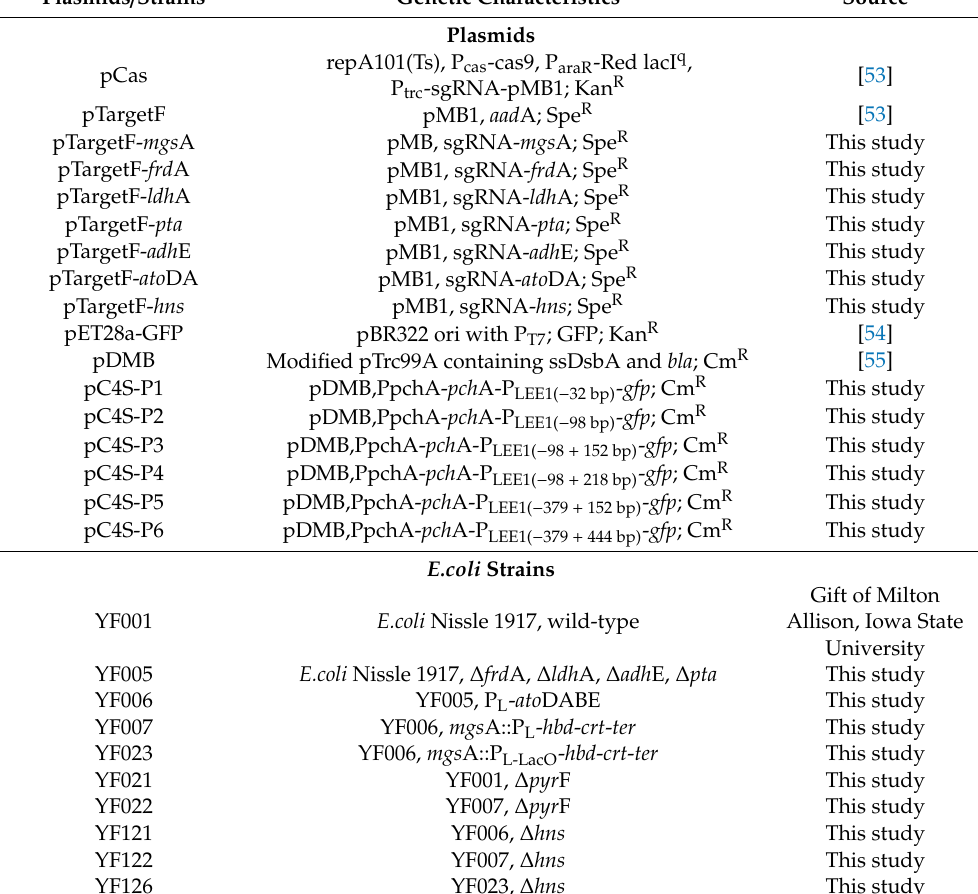
Table 1. Strains and plasmids used in this study with antibiotic resistance (e.g., Kan R ) (Kan: kanamycin, Spe: spectinomycin, Cm: